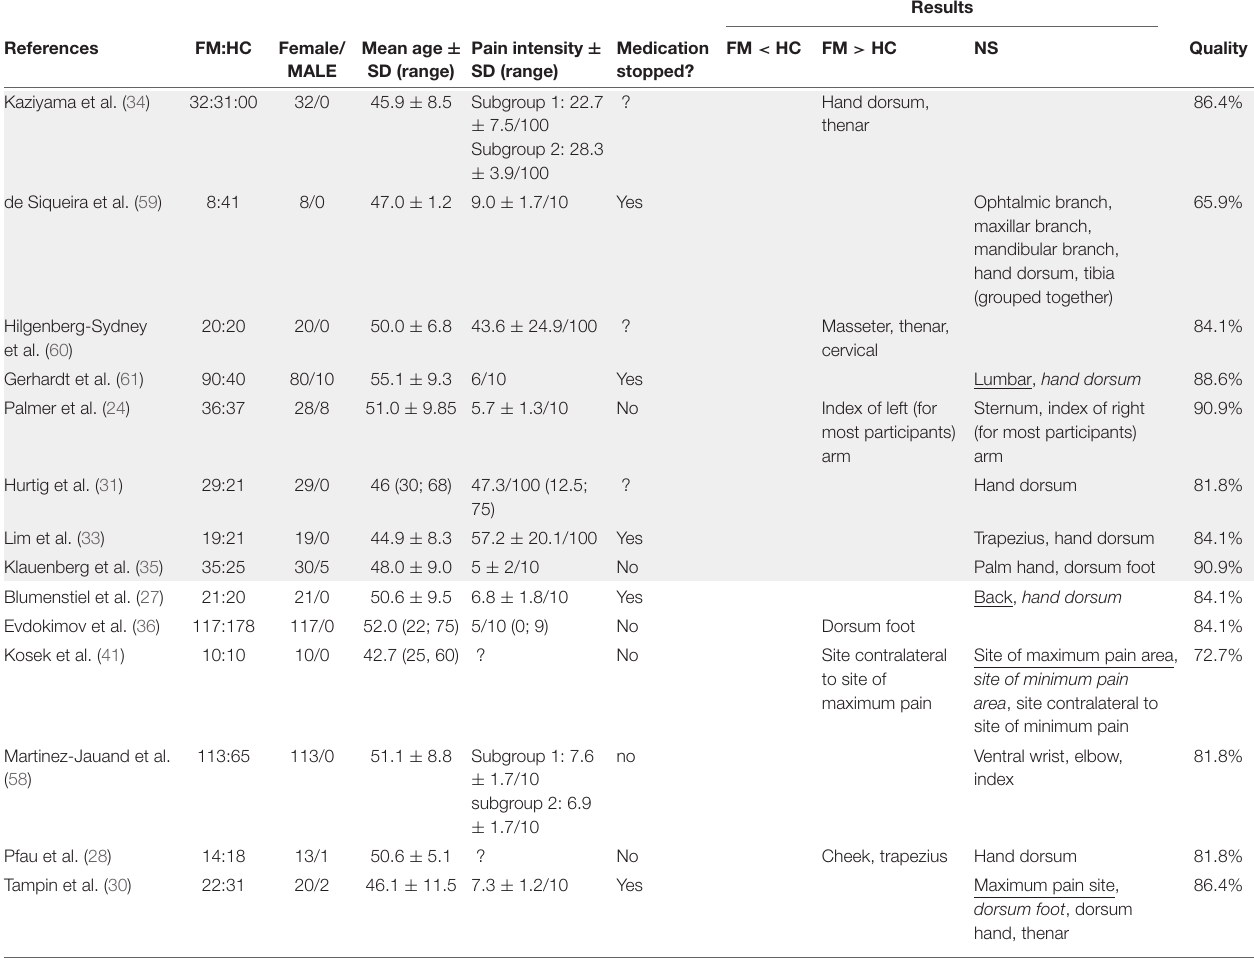
TABLE 1 | Studies included in the review with measures of